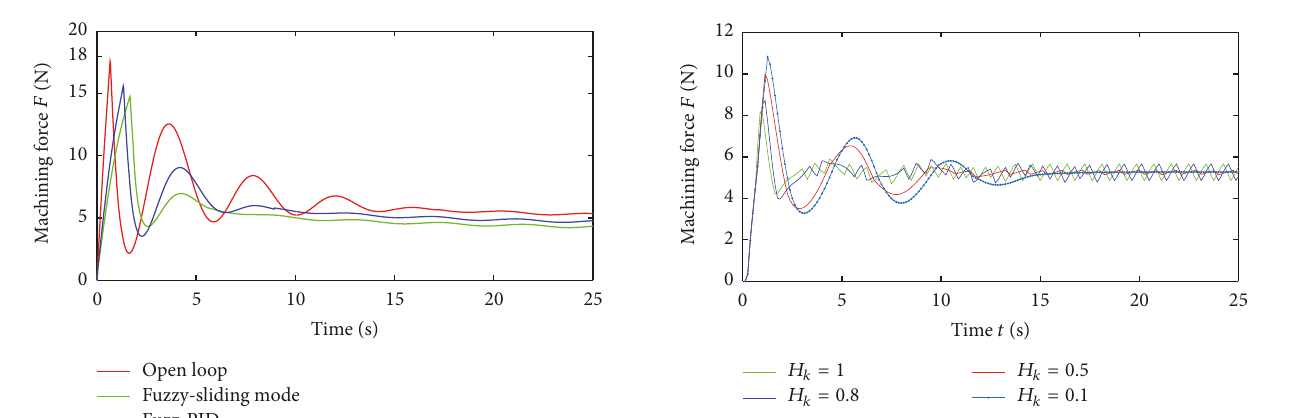
Figure 7: Impact of sliding mode control gain on cutting